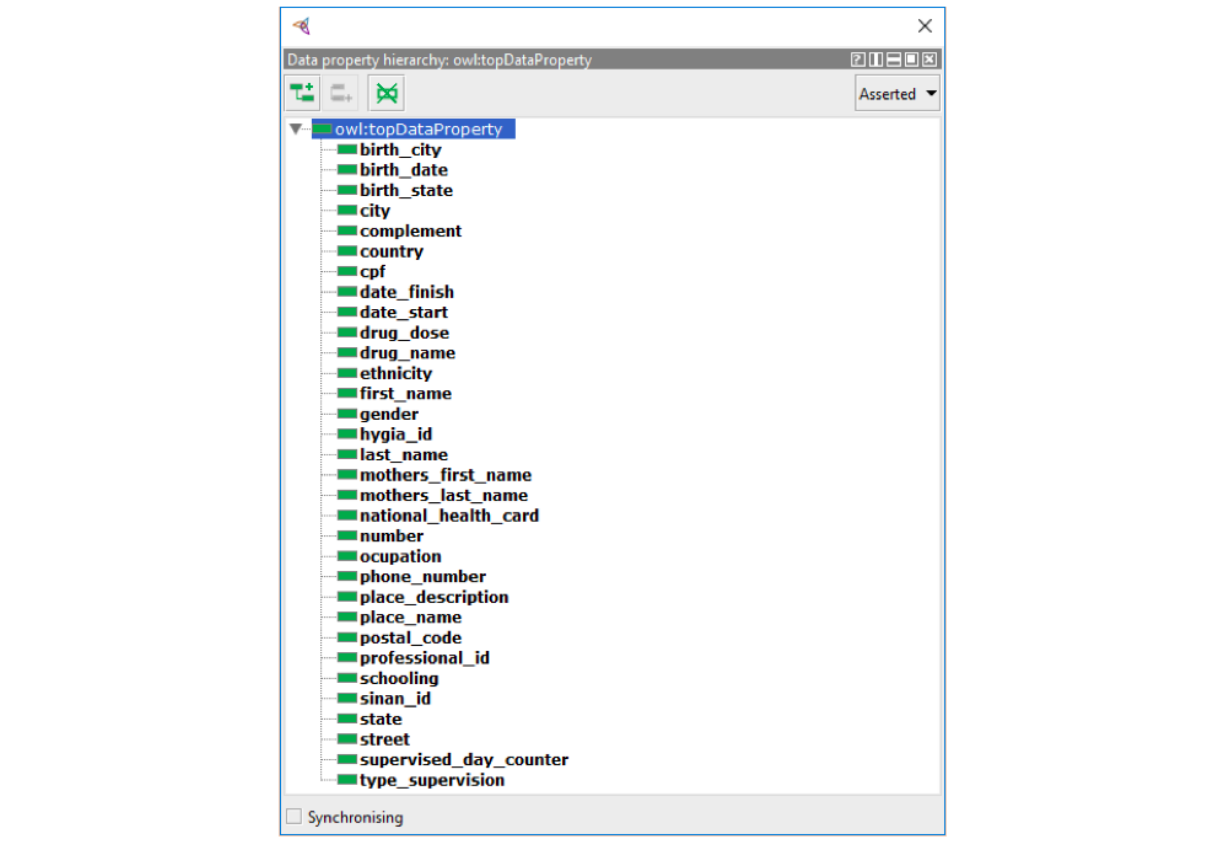
Figure 5. Translated terms that allowed the interchange of data between the